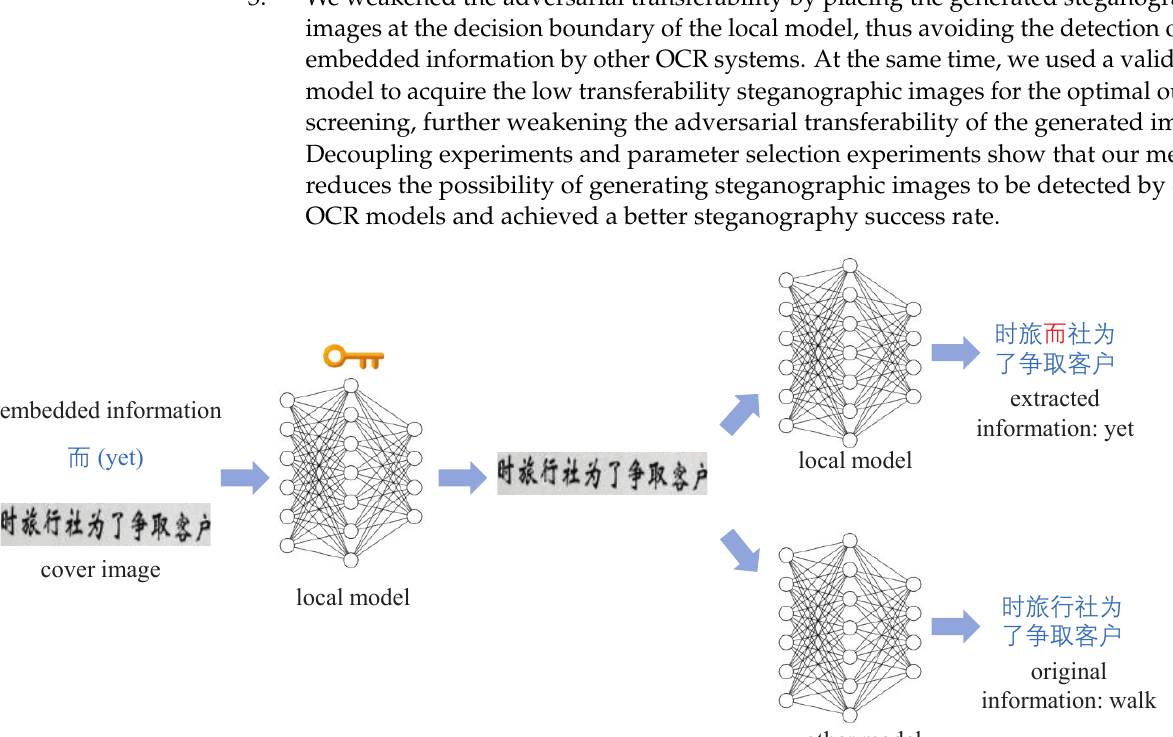
Figure 1. The schematic diagram of our steganography method. We achieve steganography by attacking the local model. We achieve steganographic message embedding by attacking the local model, and information extraction by capturing the character whose result recognized by the local model is different from the reference